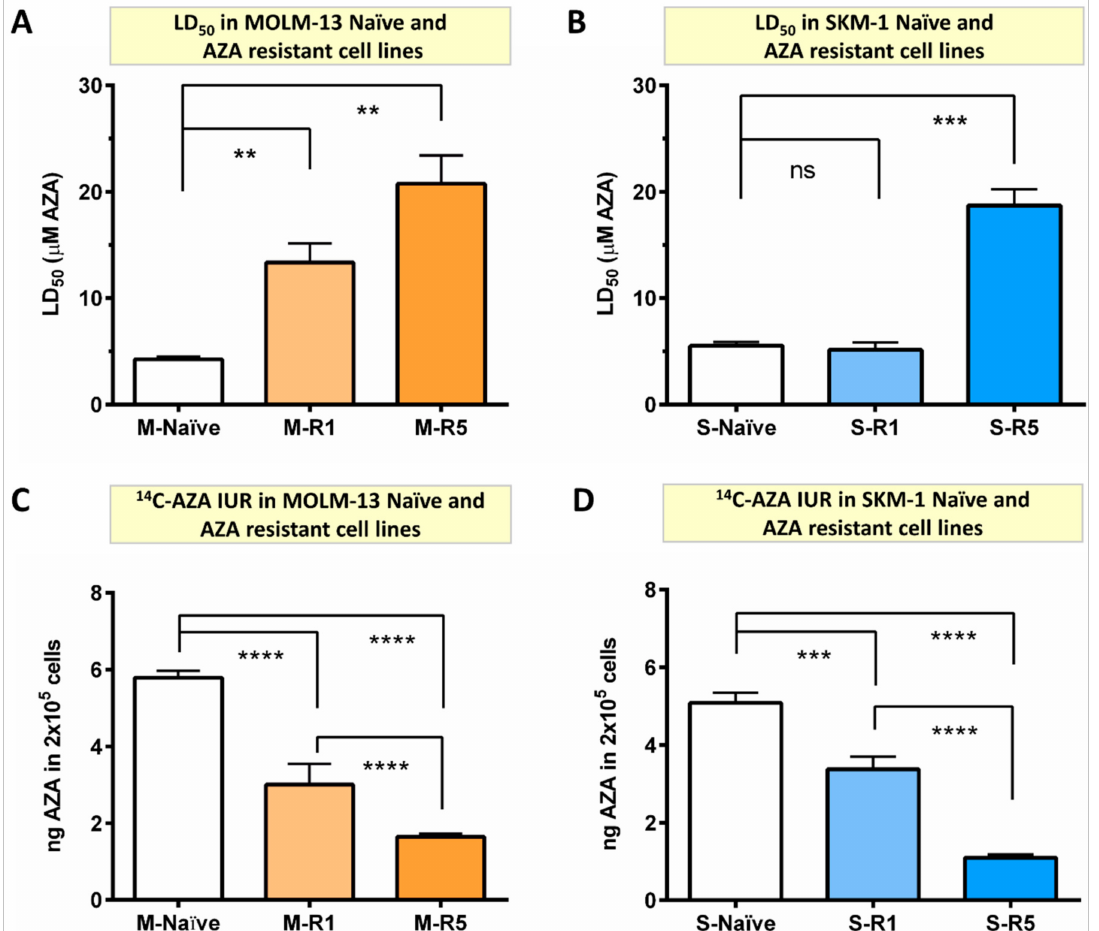
Figure 1. The 14 C-AZA intracellular uptake and retention (IUR) is significantly lower in AZA- resistant cell lines compared to parental cells. The concentration of AZA required to kill 50% of cells (LD 50 ) was determined by Annexin V/7-AAD staining. ( A ) AZA LD 50 was significantly higher in MOLM-13-resistant cells (M-R1 and M-R5) compared to naïve cells; ( B ) similarly, AZA LD 50 was significantly higher in SKM-1-resistant cells (S-R5) compared to naïve cells; Importantly, resistance is probably driven by the reduced intracellular concentration of AZA, as shown by reduced 14 C-AZA IUR in ( C ) MOLM-13- and ( D ) SKM-1-resistant cells compared to their parental cells. Data represents the mean and all error bars are indicative of SEM of at least 3 independent experiments. AZA, azacitidine; M, MOLM-13; S, SKM-1; ns, not significant. Unpaired Student’s t -test (Welch’s correction was applied for data groups with unequal SD) was used to detect statistically significant differences between cohorts. Asterisks display p -values ** p < 0.01, *** p < 0.001, **** p <